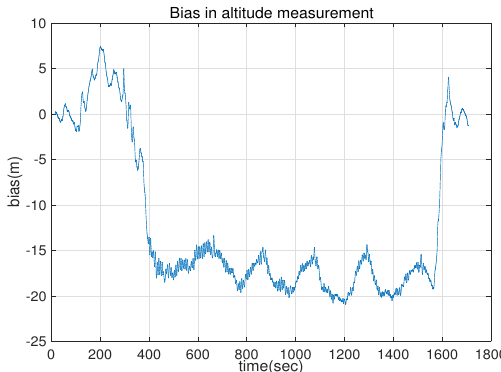
Figure 3. Estimated bias in barometric altitude measurement by